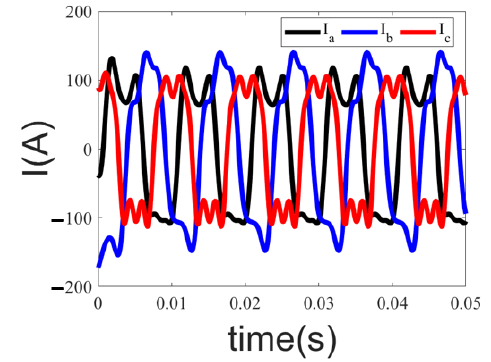
Figure 18. The waveform under the high − order